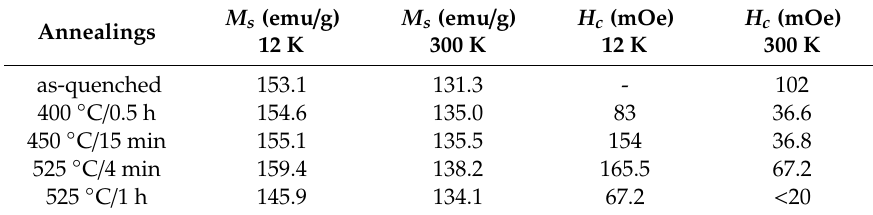
Figure 32. The frequency dependence of magnetic loss in as quenched state, after relaxation (673 K and nanocrystalline state (793 K, 1 h). Adopted from [117], with permission from Elsevier, 2003. Table 1. Saturation magnetization ( M s ) and coercivity ( H c ) measured at 12 and 300 K after isothermal heat treatments. Adopted from [116], with permission from Elsevier,